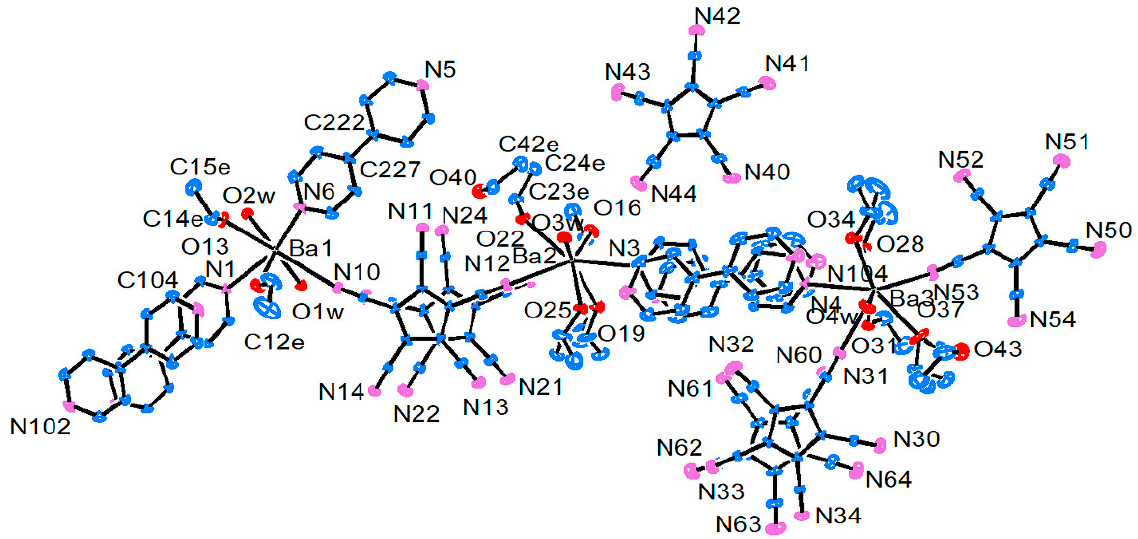
Figure 19. The asymmetric unit in the crystal of compound 5 . Figure 19 . The asymmetric unit in the crystal of compound 5 . Figure 19 . The asymmetric unit in the crystal of compound 5 .